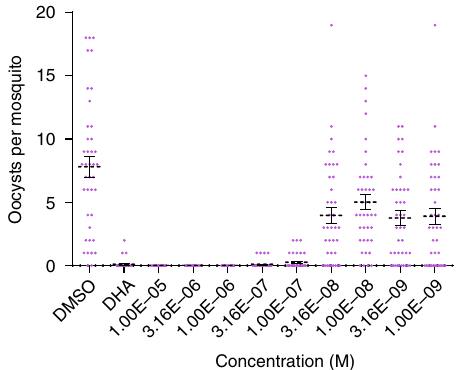
Fig. 3 Transmission-blocking activity of ML10. P. falciparum (NF54) gametocytes were incubated for 24 h with nine different concentrations of ML10 and were each fed to a separate cage of 30 – 40 Anopheles stephensi mosquitoes using a SMFA. Up to 20 surviving mosquitoes were dissected on day 7 post-feed and oocyst numbers assessed by microscopy. This experiment was performed twice and the fi gure shows the combined data for oocyst intensity in each mosquito as a function of the compound concentration for the replicate feeders. The left segment of the x -axis shows the oocyst intensities in the vehicle (0.1% DMSO) controls. The positive